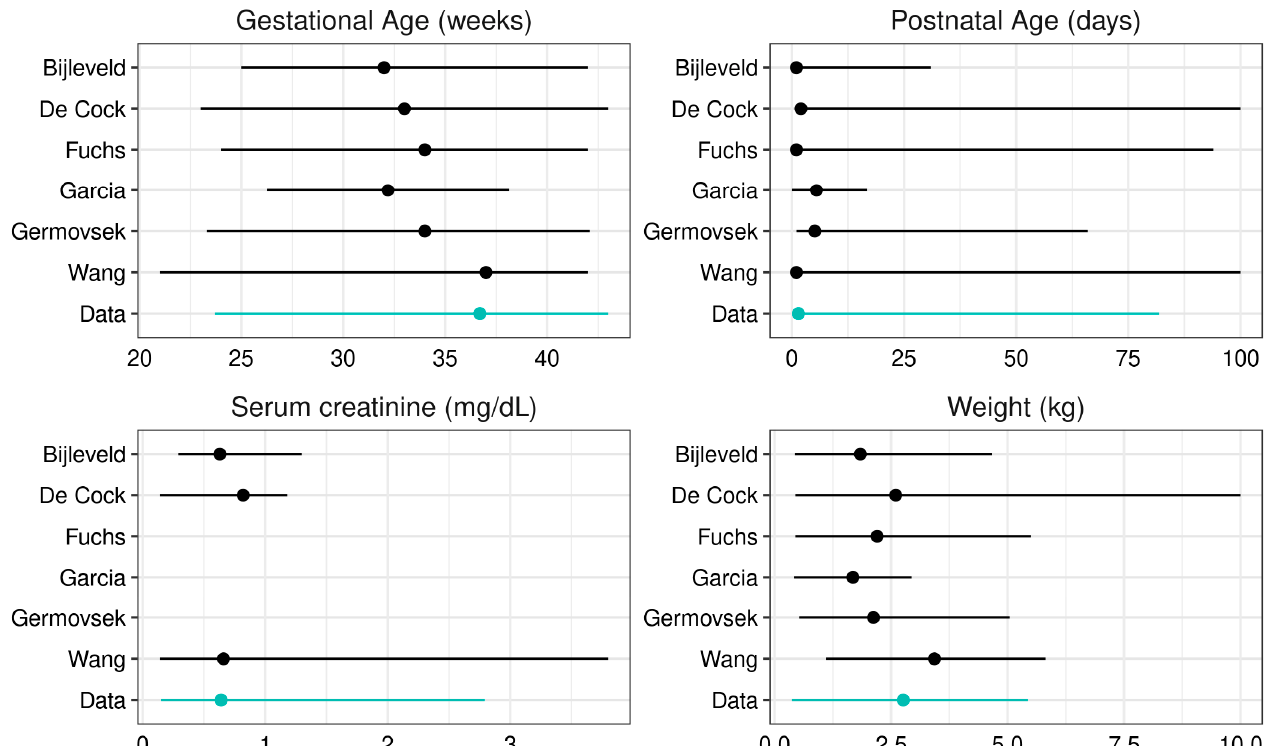
Figure 3. Model development population covariate distributions. Dots (lines) represent median (range), except for Garcia covariates, which are given as mean (two times standard deviation). Postnatal age is cropped to 100 days and weight cropped to 10 kg for clarity.